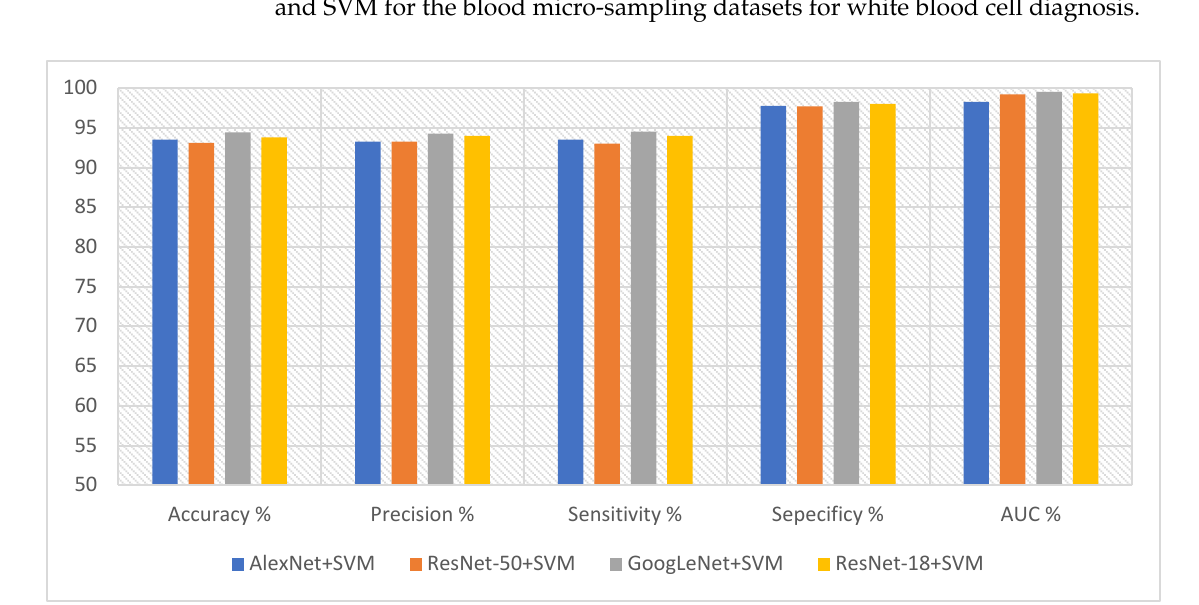
Figure 18. Display showing the performance of the hybrid CNN models and SVM.